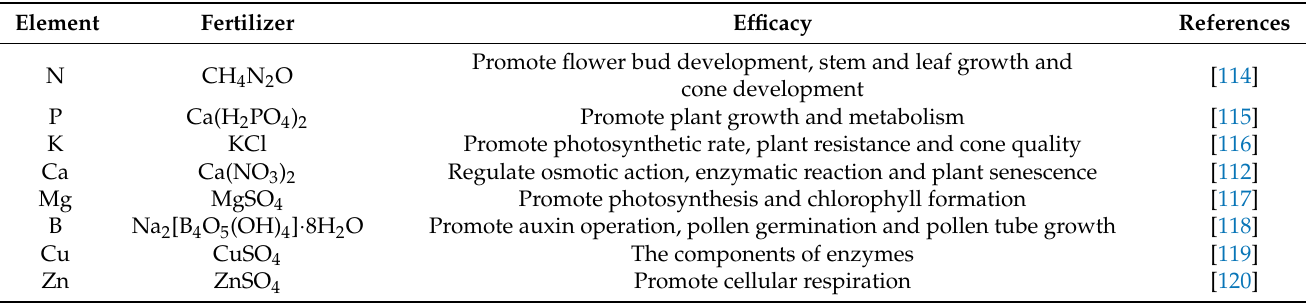
Table 1. Fertilizer commonly used in conifer